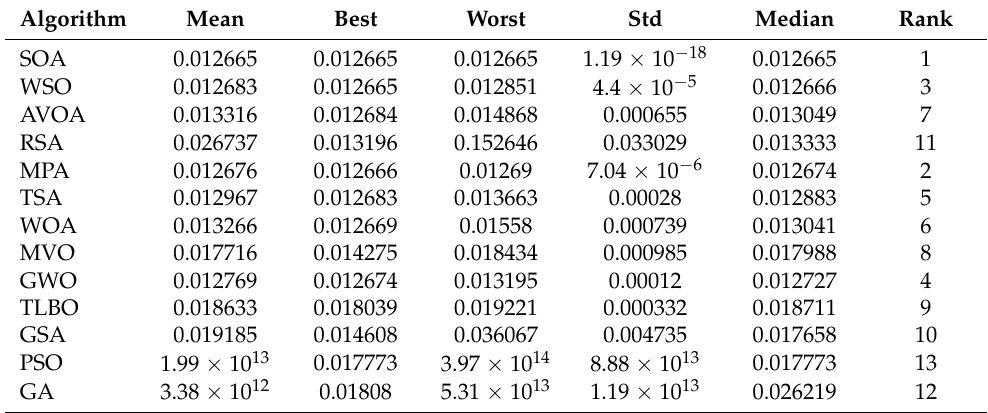
Table 16. Statistical results of optimization algorithms on the tension/compression spring de- sign problem.